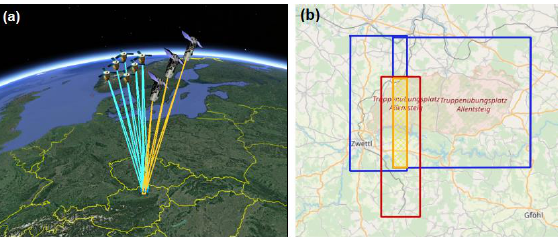
Figure 1. Study area (a) Acquisition geometries of Pléiades (blue) and WorldView-3 sensors (orange) in Google Earth; (b) acquisition footprints with marked common study area (yellow) overlaid on Open Street Map (OSM) All images were delivered as pan-sharpened with four bands (Red, Green, Blue and Near-infrared). Depending on the different viewing angles, the spatial resolutions are varying between 0.70 - 0.71 m and 0.31 – 0.32 m for Pléiades and WorldView-3 images, respectively. For each image, the Rational Polynomial Coefficients (RPCs), allowing the conversion between image and object space, were provided by the supplier. Detailed information regarding the acquisition properties for all the tri-stereo datasets are shown in Table 1.